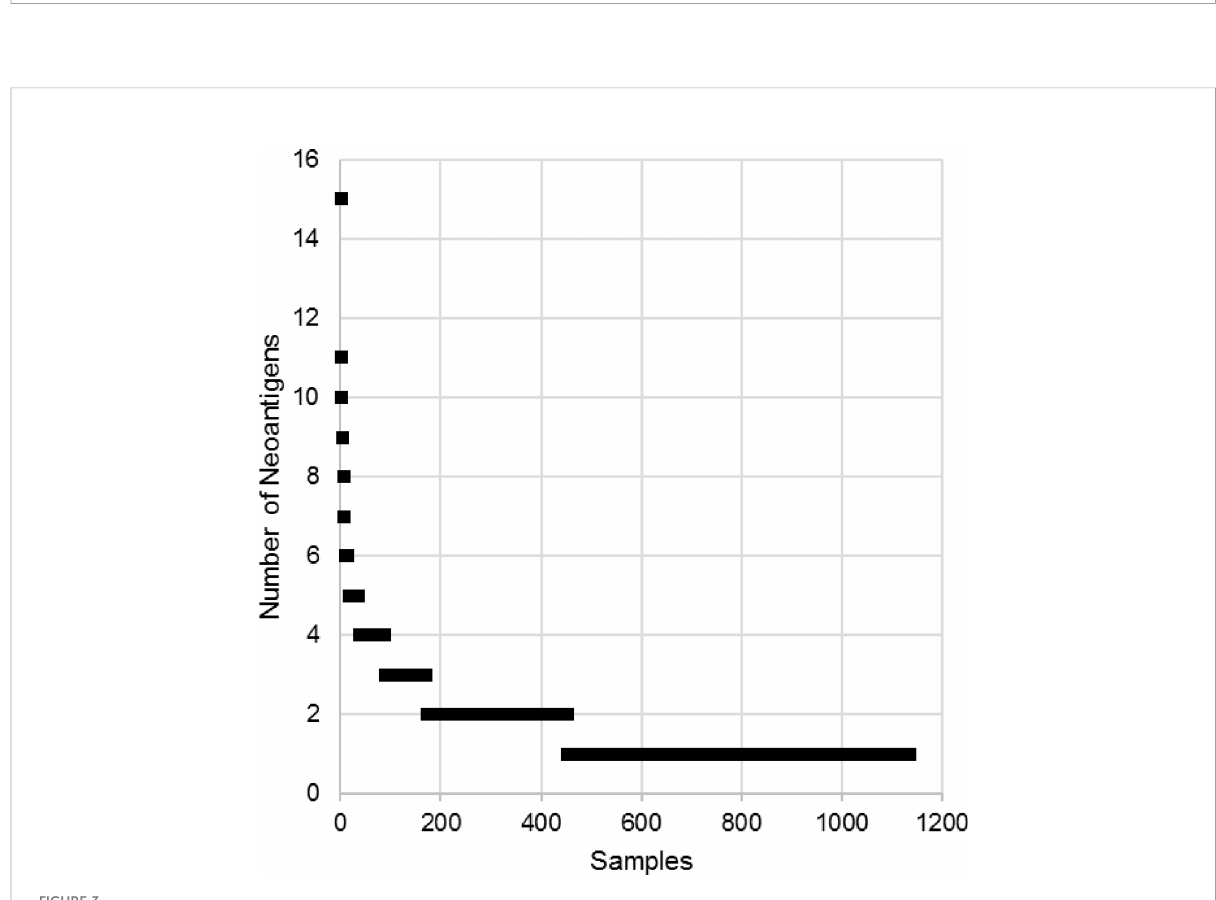
FIGURE 3 The number of neoantigens in each